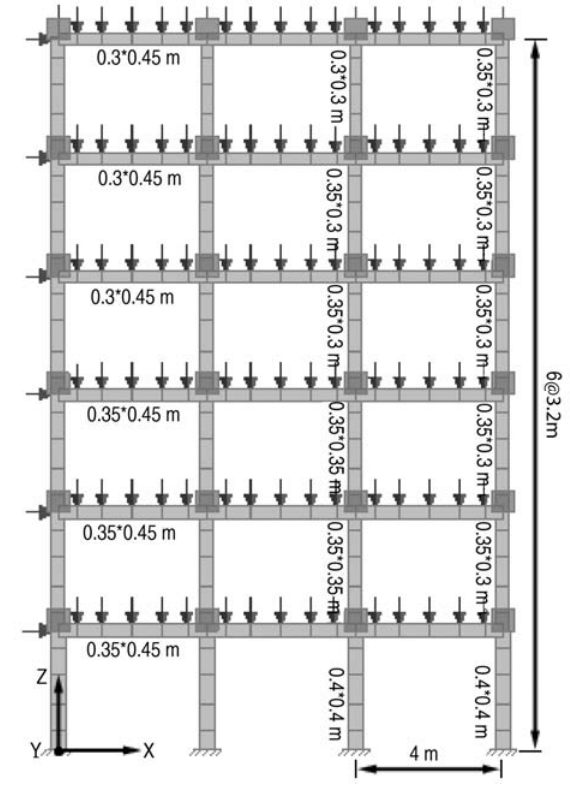
Fig. 2. Geometrical data of finite element model of